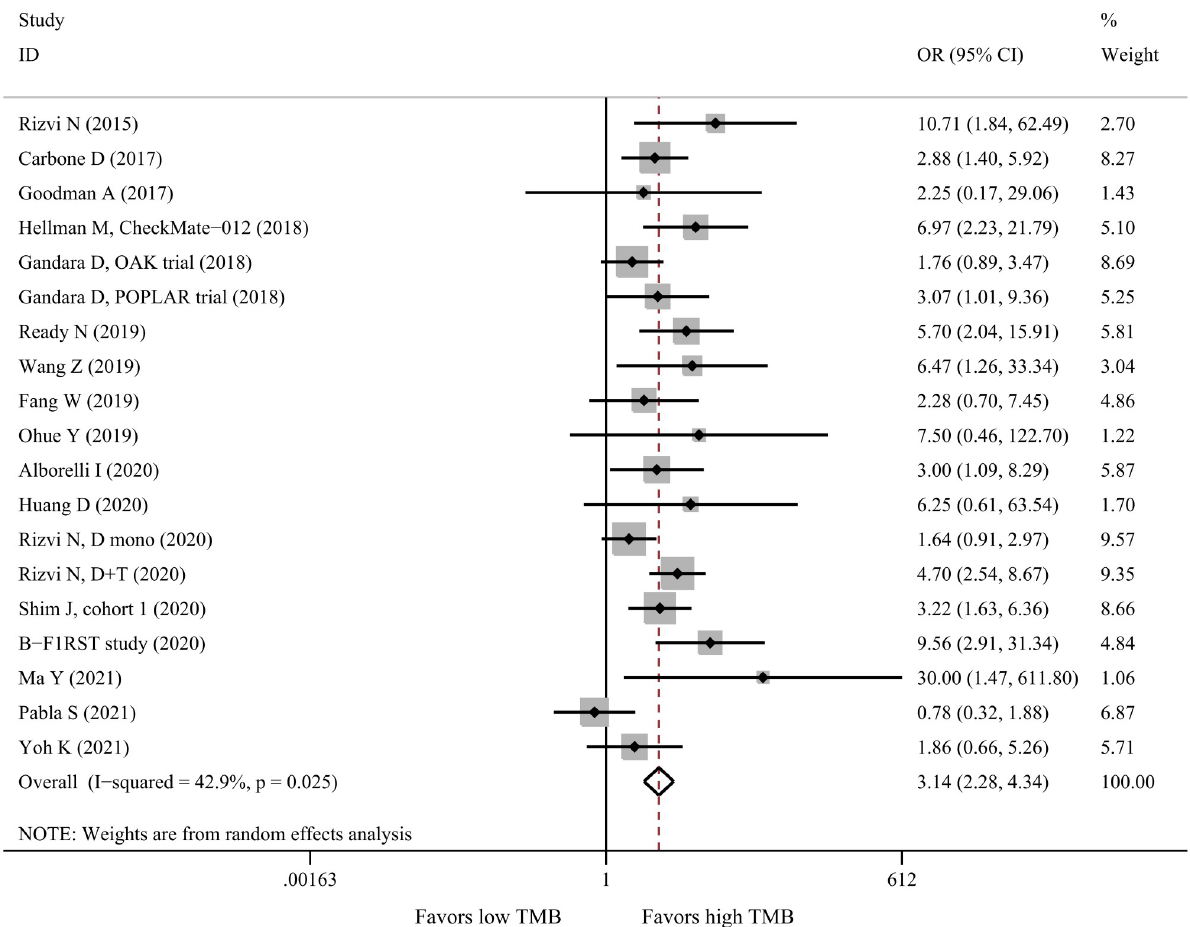
Fig 4. Forest plot for ORR of high-TMB versus low-TMB in NSCLC patients receiving immunotherapy. OR: Objective response rate; TMB: Tumor mutational burden; NSCLC: Non-small cell lung cancer; OR: Odds